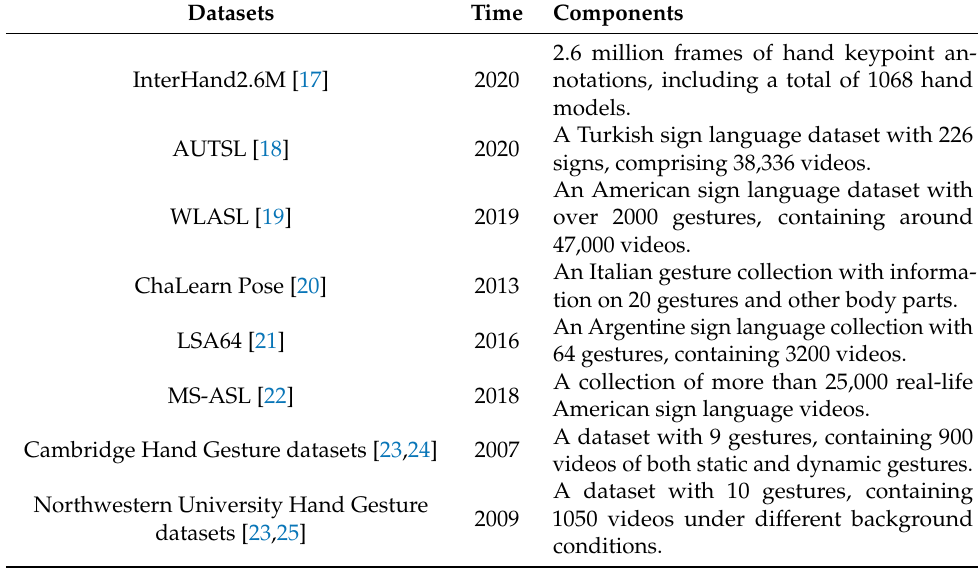
Table 1. Collection of